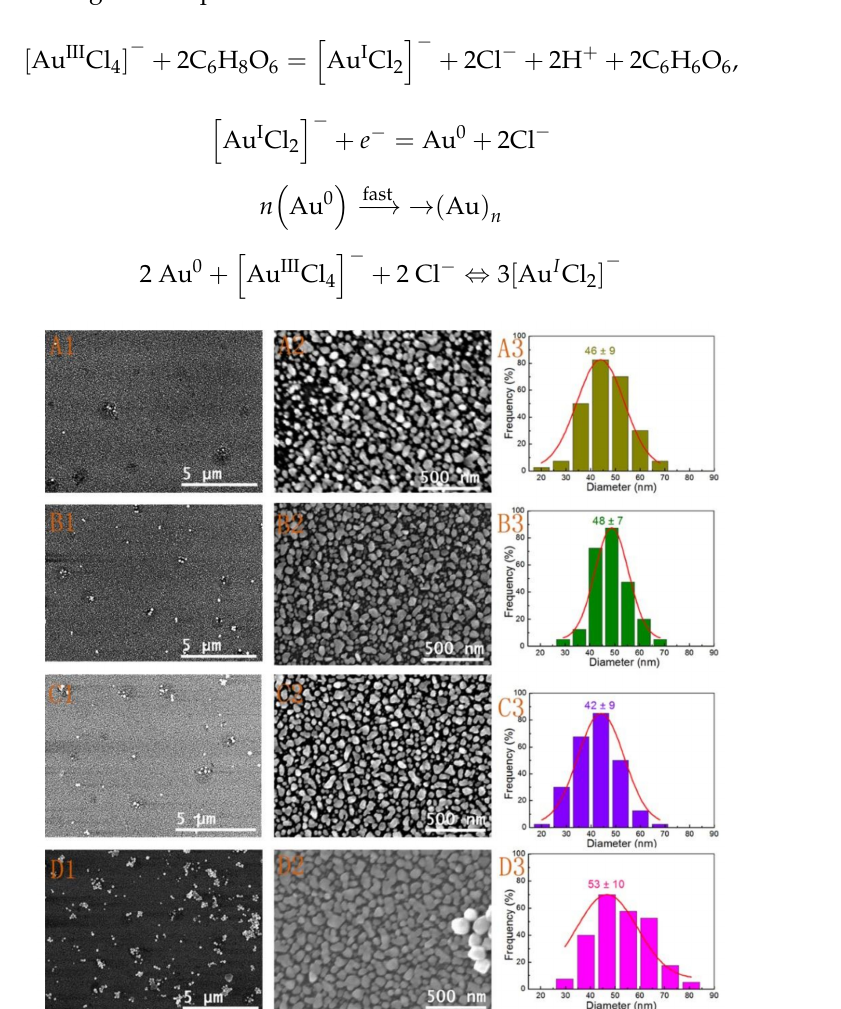
Figure 5. SEM images ( A1 , A2 , B1 , B2 , C1 , C2 , D1 , D2 ) and size distributions ( A3 , B3 , C3 , D3 ) of the obtained Au nanoparticle films after activating with seed II and soaking with different reaction times: ( A1 – A3 ) 15 min, ( B1 – B3 ) 30 min, ( C1 – C3 ) 5 h, ( D1 – D3 ) 20 h. The fabricated substrate was activated by seeds II and combined with immersion time of 12 h showed in Figure